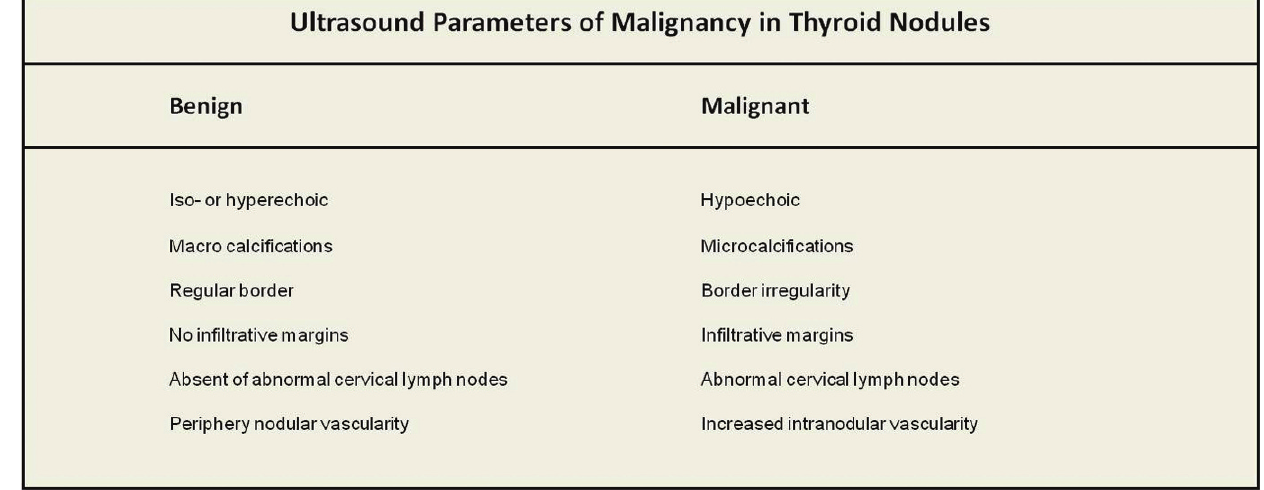
Figure 1 - Ultrasound parameters suggestive of malignancy in thyroid nodules. Adapted from Lew et al.